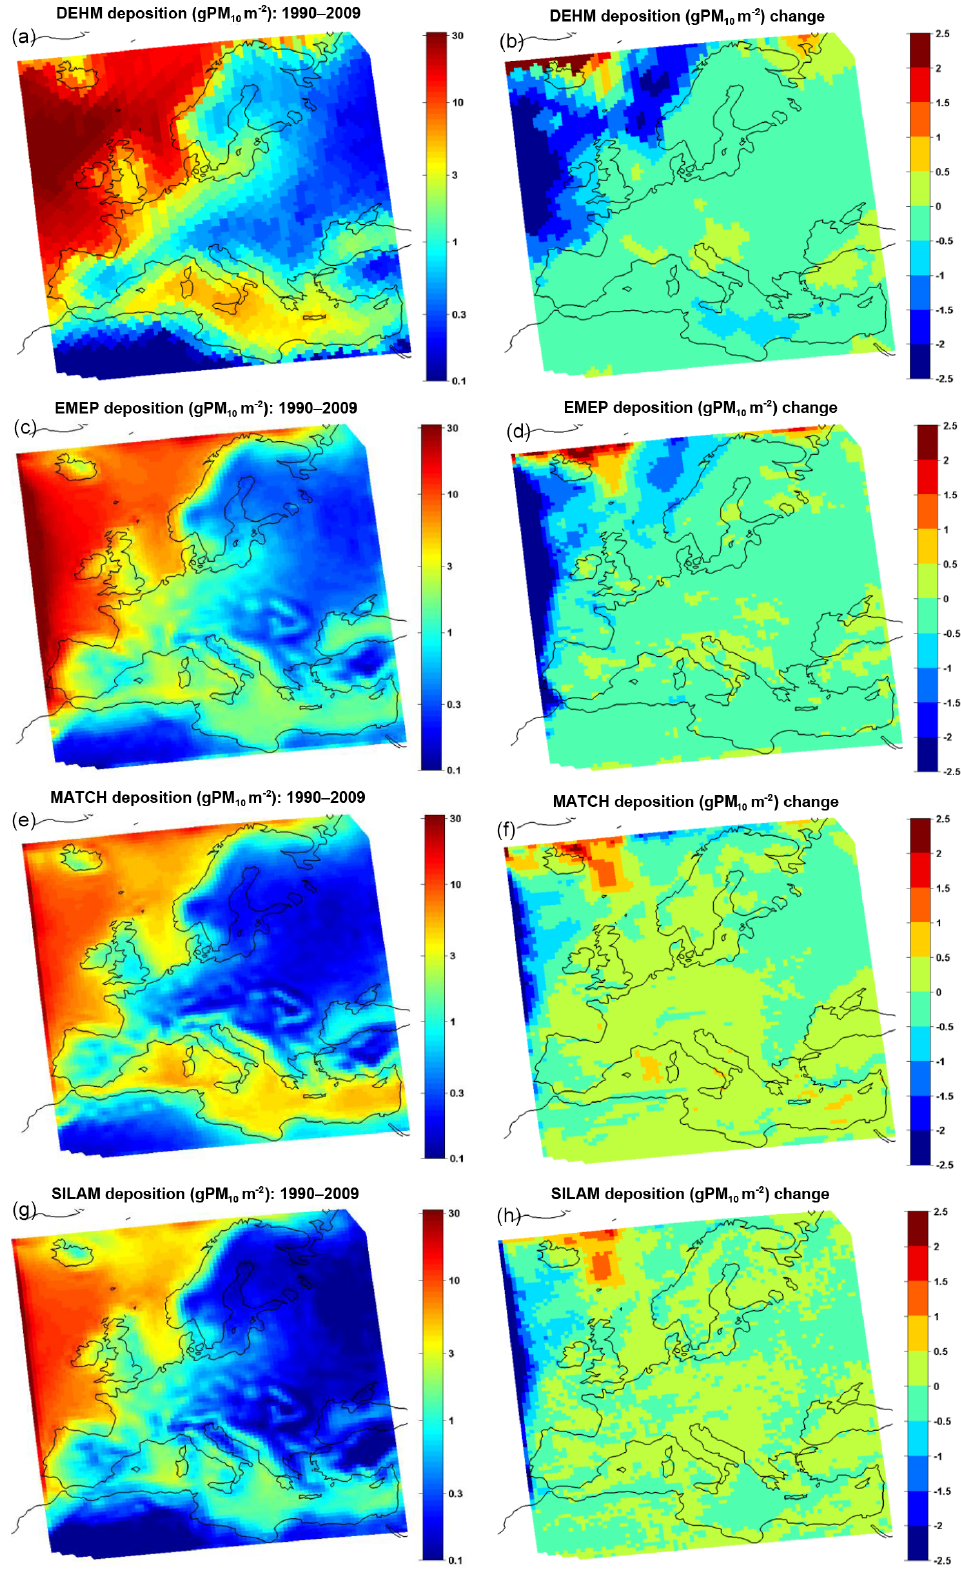
Figure 7. Sea salt deposition (wet + dry) (mgPM 10 m − 2 ) for DEHM, MATCH, EMEP, and SILAM models. Left panels: mean value for the past period (1990–2009); right panels: absolute difference between the future (2040–2059) and past